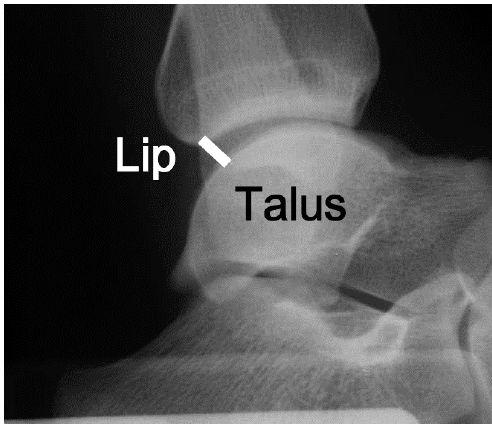
Figure 4. The distance between the tibia and the talus was measured during the X-ray imaging test. The white solid line represents the shortest distance between the tibia and talus. ‘Lip’ indicates the posterior lip of the